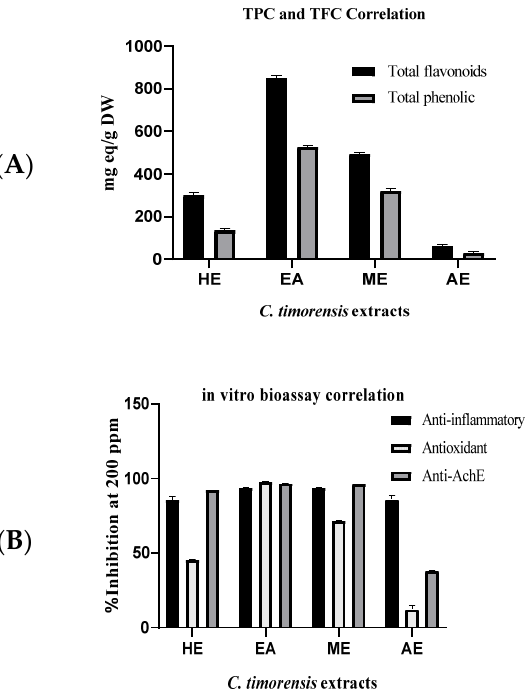
Figure 2. ( A ) Relationship between total phenolic content and total flavonoid content of Cassia timoriensis extracts. ( B ) Relationship between total phenolic content and flavonoid content with in vitro bioassays for Cassia timoriensis flower extracts.